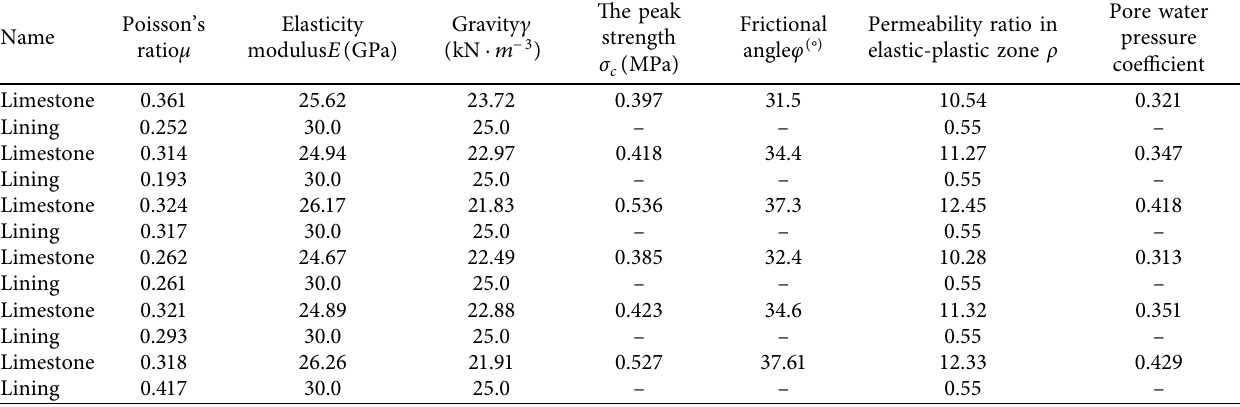
Table 2: Mechanical parameters of surrounding rock in the roadway and calculated parameters of lining.